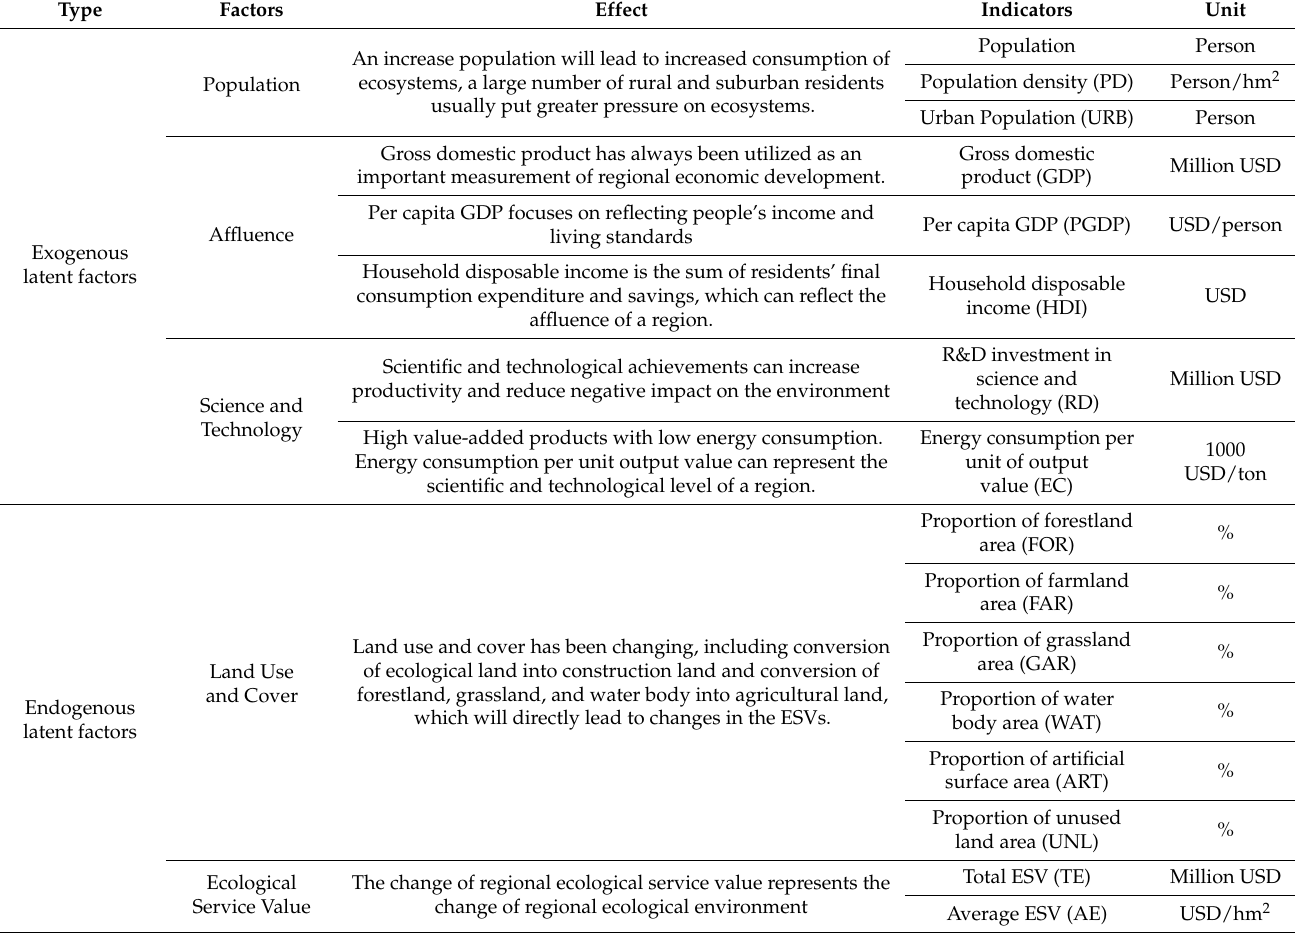
Table 3. Driving factors of the changes of